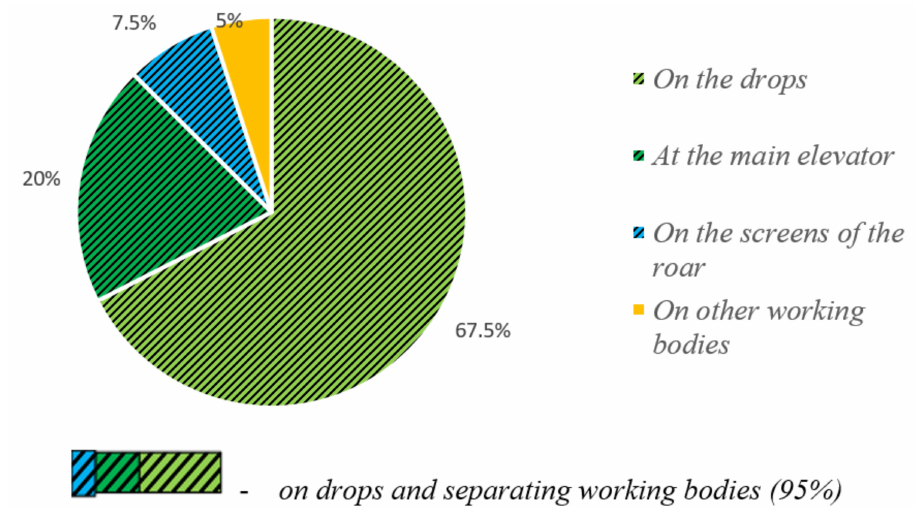
Figure 6. Specific gravity of damage to potato tubers on drops and separating working bodies as a percentage of the total amount of damage by